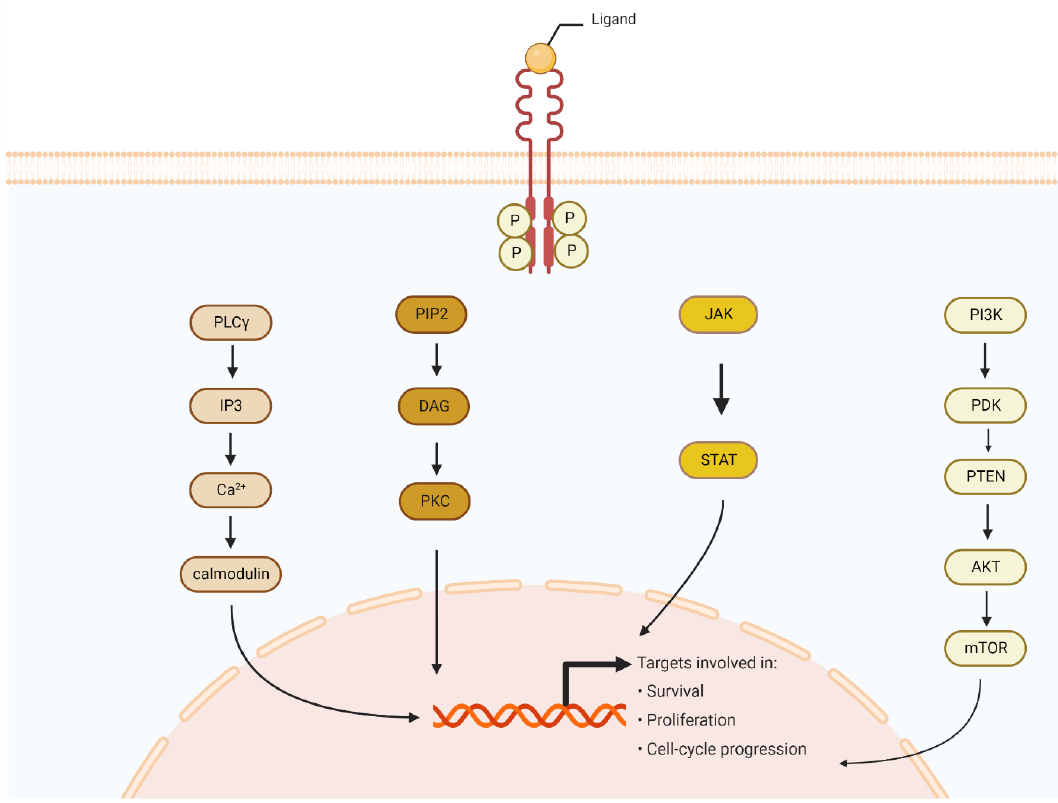
Figure 3. The FGF signalling pathway. The ligand binds to an FGFR monomer, which leads to dimerization and intracellular phosphorylation. This provides the means to start signalling pathways for FGFRs. Activated FGFRs open the way for PI3K, AKT, mTOR or the RAS/RAF/MEK/MAPK cascade. Activated FGFRs also phosphorylate JAK kinases, which lead to STAT activation. FGFRs can also recruit and phosphorylate PLCγ, thereby initiating signalling through the DAG/PKC or IP3-Ca2+ pathway. All of those pathways have a crucial role in tumour development. FGFR (fibroblast growth factor receptors); PI3K (phosphoinositide 3-kinase); AKT (protein kinase B); mTOR (mammalian target of rapamycin); JAK (Janus kinase); STAT (signal transducer and activator of transcription); PLCγ (phospholipase C gamma ); DAG (dystroglycan); PKC (protein kinase C); IP3 (inositol trisphosphate).